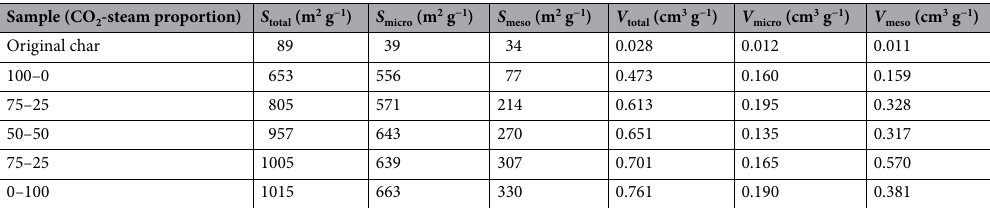
Table 2. Pore volumes and surface areas of activated